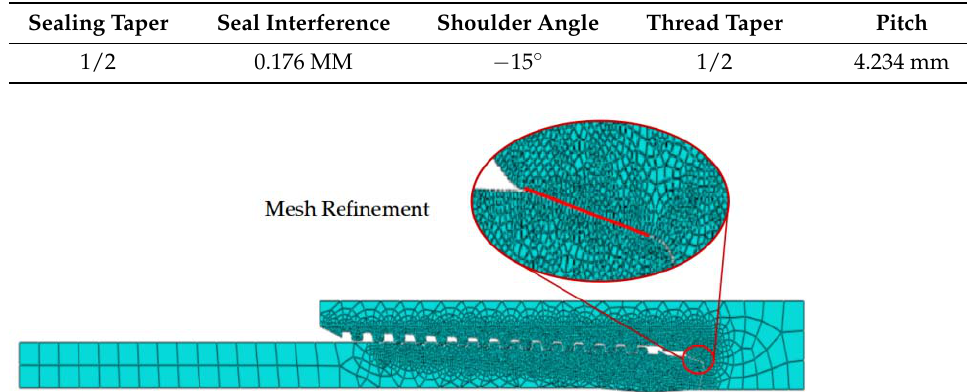
Table 1. Design parameters of the premium connection.